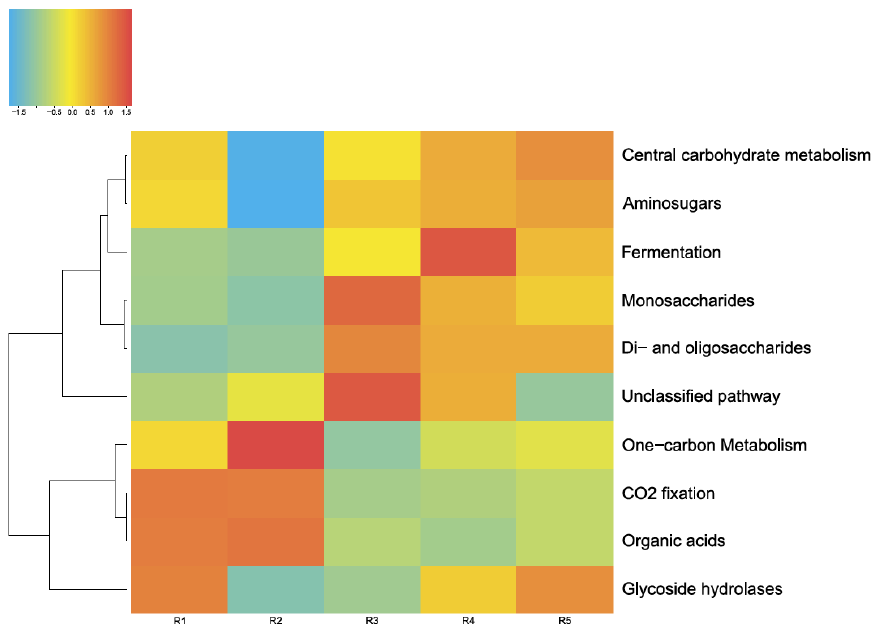
Figure 9. Pathways of carbon metabolism in the microbial communities of the lake. The color range: − 1.5 is the lowest relative abundance of genes involved in a metabolic process, and 1.5 is the highest relative abundance.